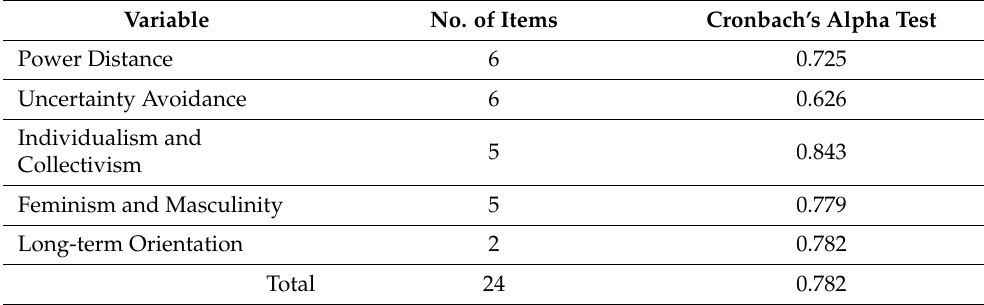
Table 1. Cronbach’s Alpha Test.